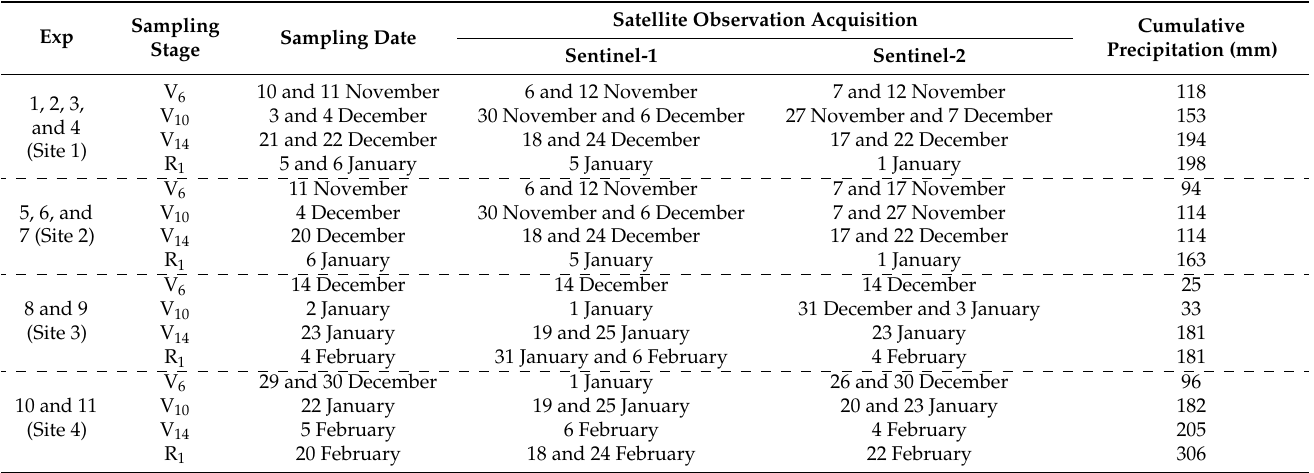
Table 2. Dates of sampling, satellite observations, and cumulative precipitation since planting for